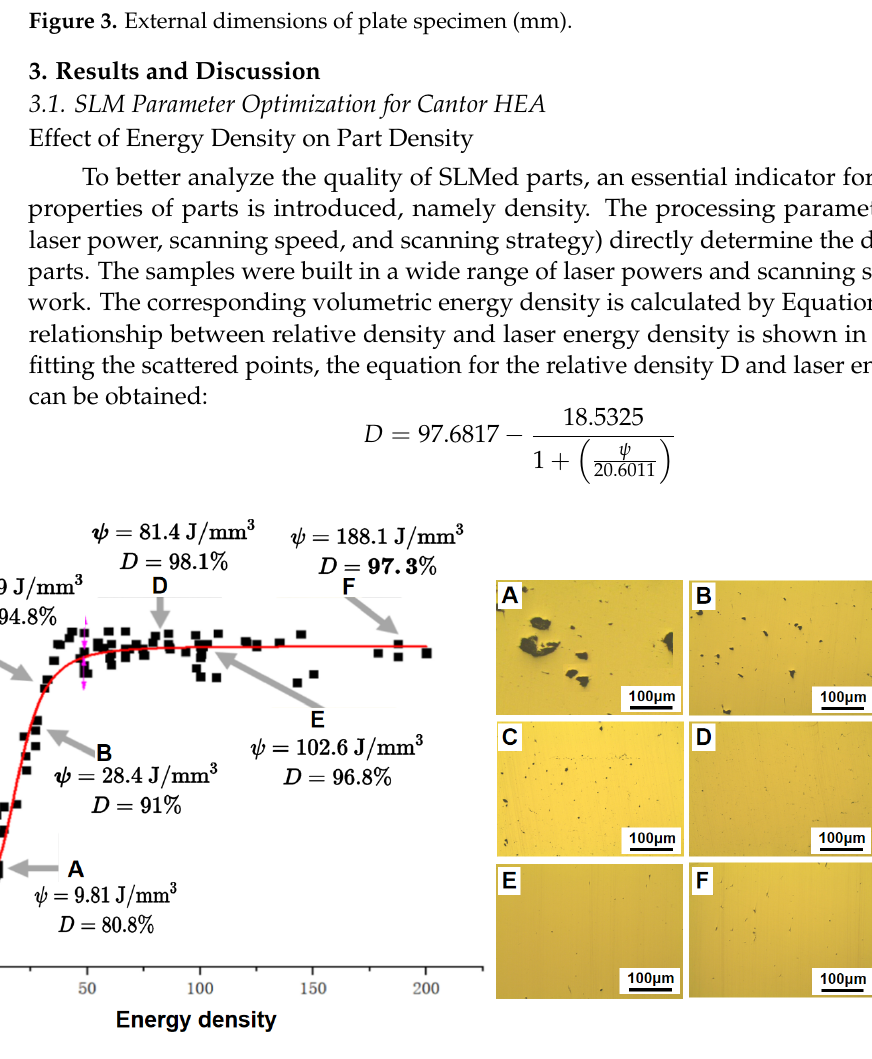
Figure 4. Relationship between energy density and SLMed part density.